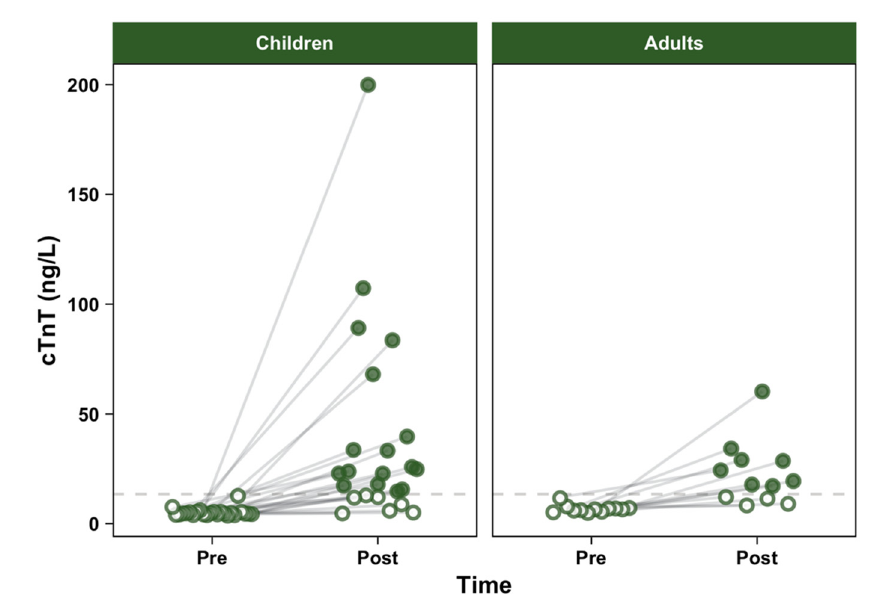
Figure 1. Individual values of cardiac troponin T (cTnT) before and after the match, by group. Correlations between basal values of cTnT, delta cTnT changes, participant characteristics and performance are detailed in Table 3. Baseline concentrations correlated positively with age ( p < 0.001), body mass ( p = 0.001), body height ( p < 0.001), and years of previous experience ( p = 0.001). Post-